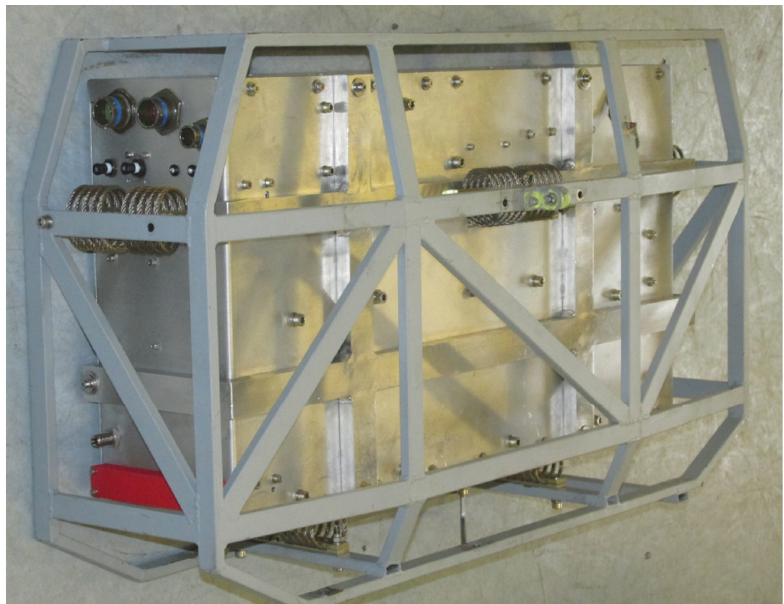
Figure 3. Picture of the external appearance of COLD2 inserted in the rack, before installation into the dome of the M55 Geophysica stratospheric